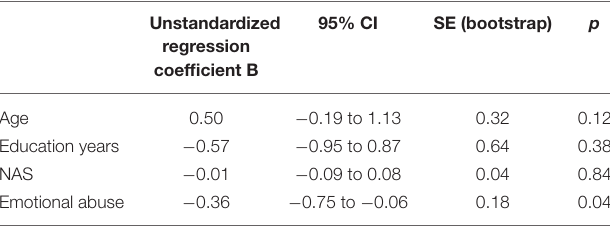
TABLE 2 | Bootstrapping regression of emotional abuse on the 1 P2 amplitude for disgust